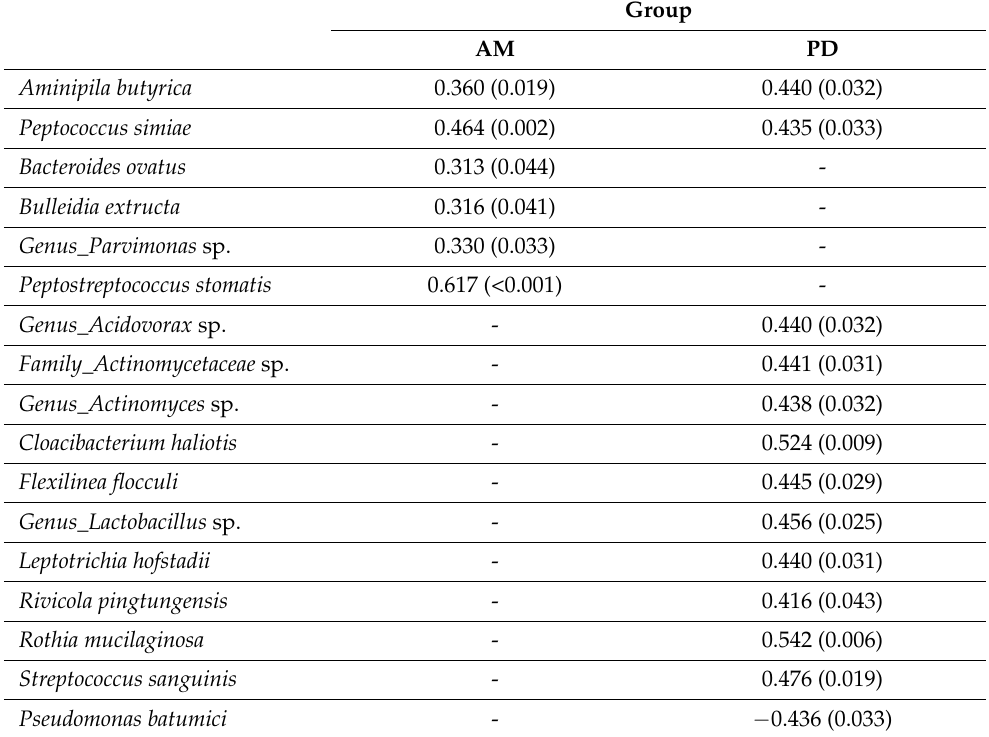
Table 2. Correlation between the subgingival microbiota composition and ACPA levels in groups AM and PD.